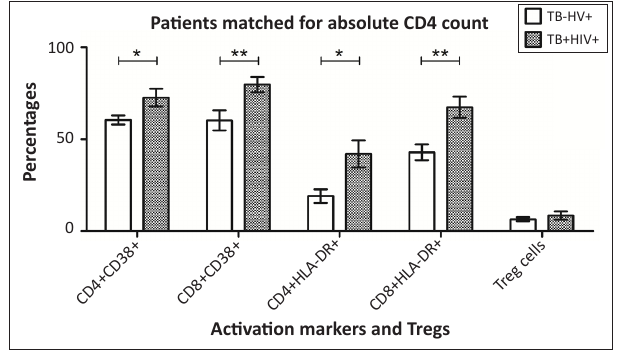
FIGURE 3 : T-cell activation markers. Representative column bars show percentages of (A) CD4 + CD38 + , (B) CD8 + CD38 + , (C) CD4 + HLA-DR + and (D) CD8 + HLA-DR + T-cells in the TB–HIV– ( n = 10), TB+HIV– ( n = 19), TB–HIV+ ( n = 20) and TB+HIV+ ( n = 20) groups.